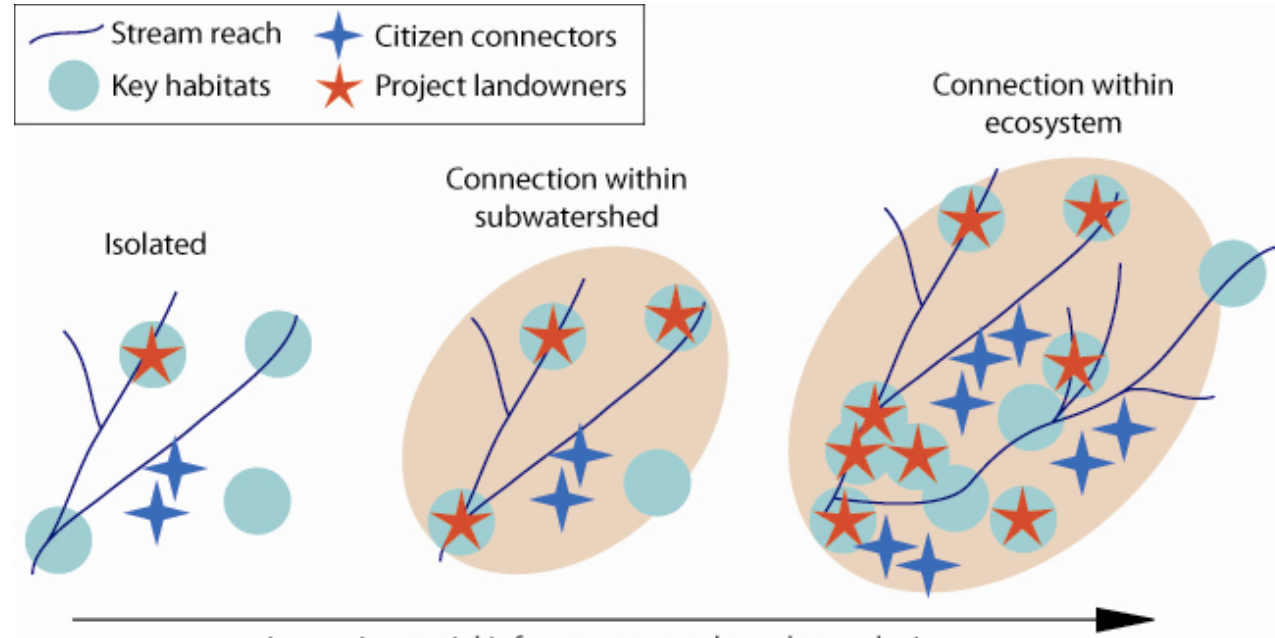
Fig. 4. As relationships among landowners and the LTWC develop through the growth of social infrastructure, the focus of projects moves from isolated project location to concerted efforts among multiple landowners within the same subwatershed to large-scale projects that address issues at the scale of the ecosystems. As the social infrastructure grows, watershed residents become citizen connectors facilitating learning and projects among their neighbors, and the number of individual landowners willing to be involved in the restoration of ecologically important habitat